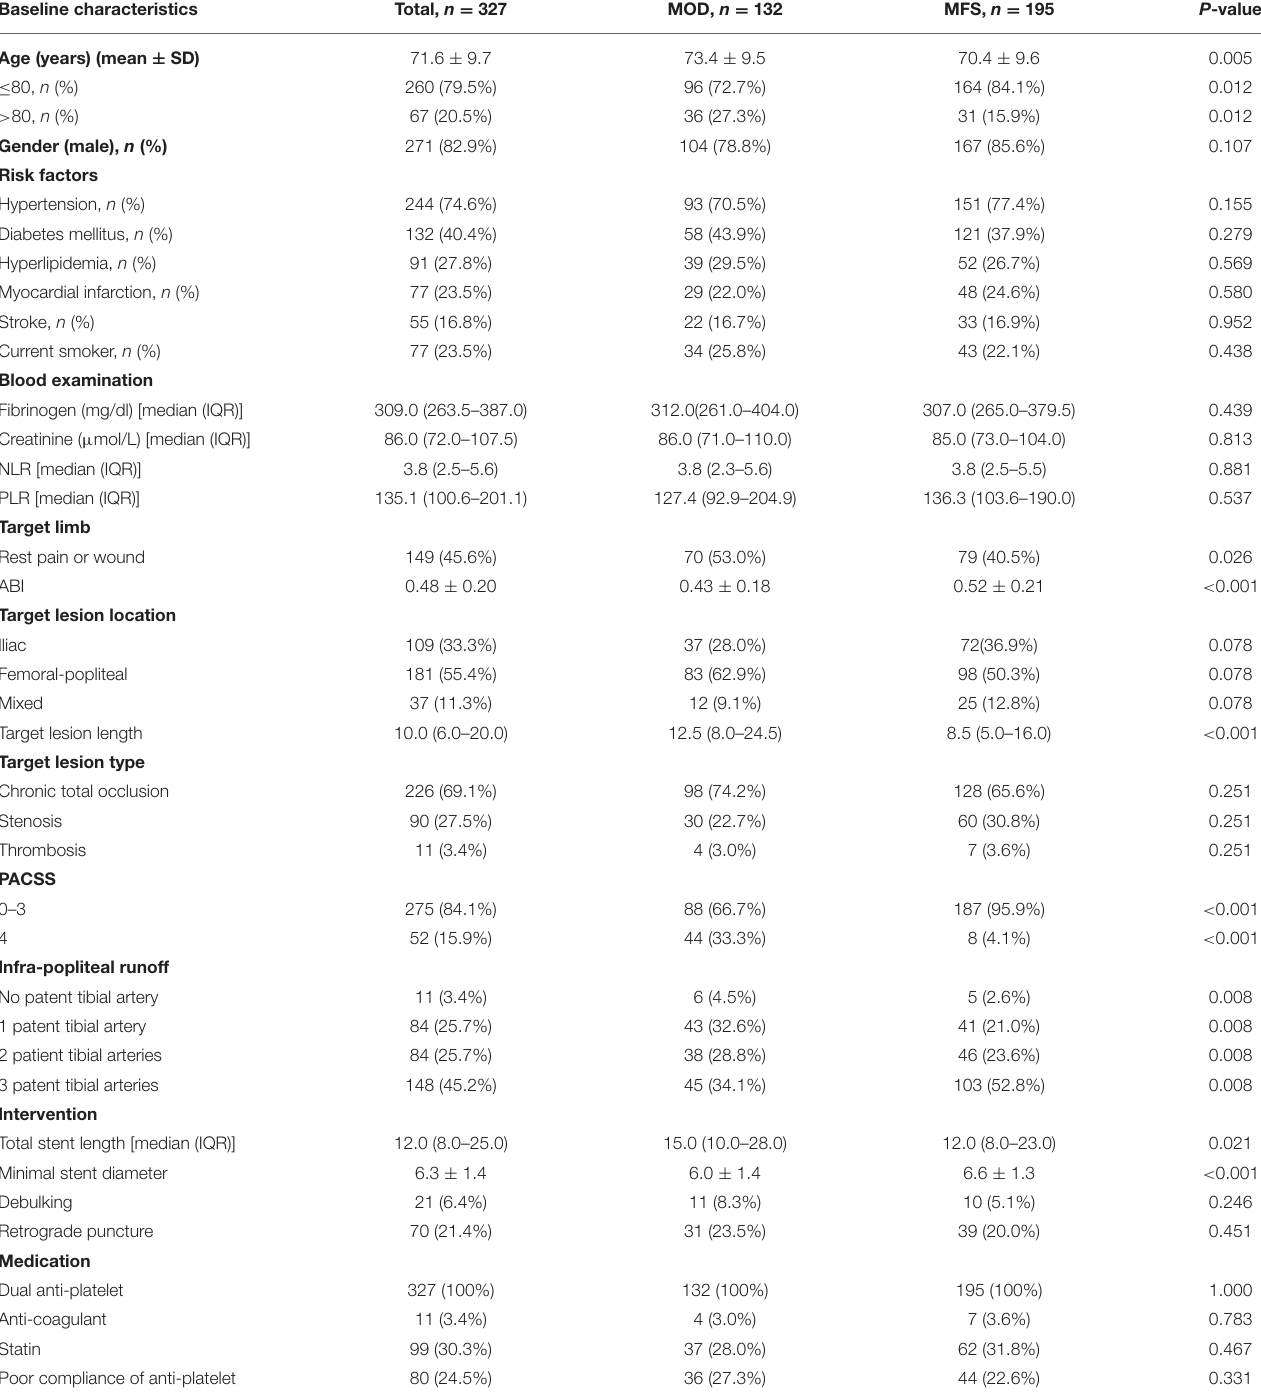
TABLE 1 | Baseline characteristics of the training